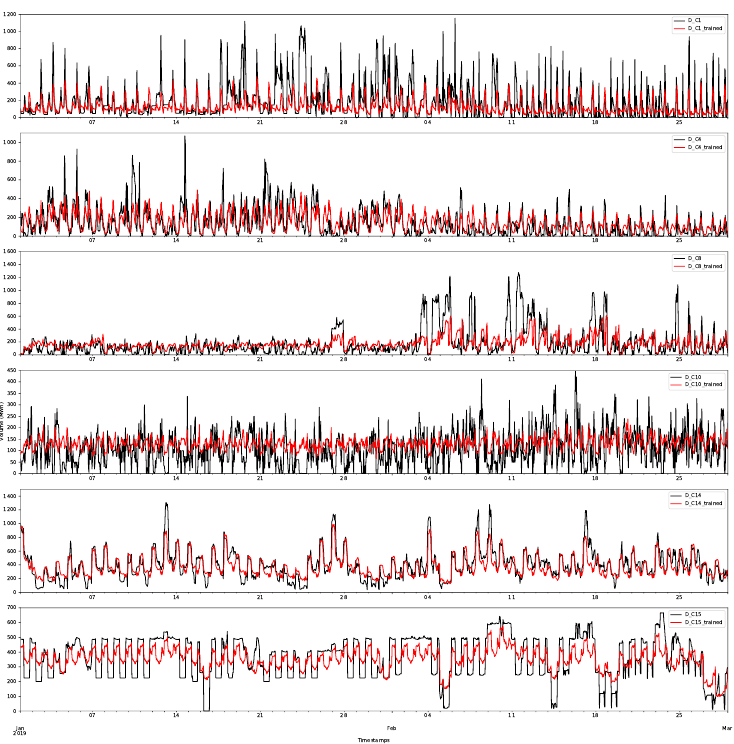
Figure A3. Examples of day-ahead forecasts for several classes for demand. The forecasts are in red and the actuals in black.